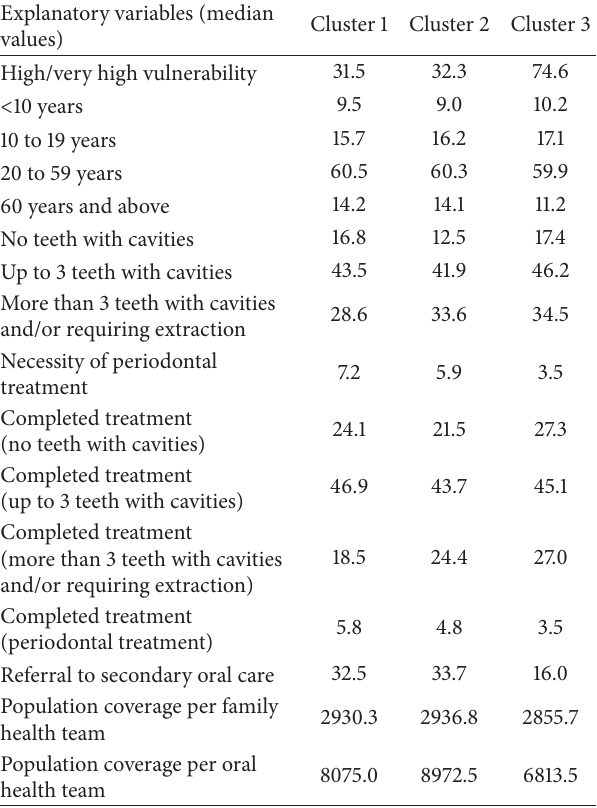
Table 3: Median values of demographic and dental treatment need indicators and health care services indicators in each cluster, Belo Horizonte,